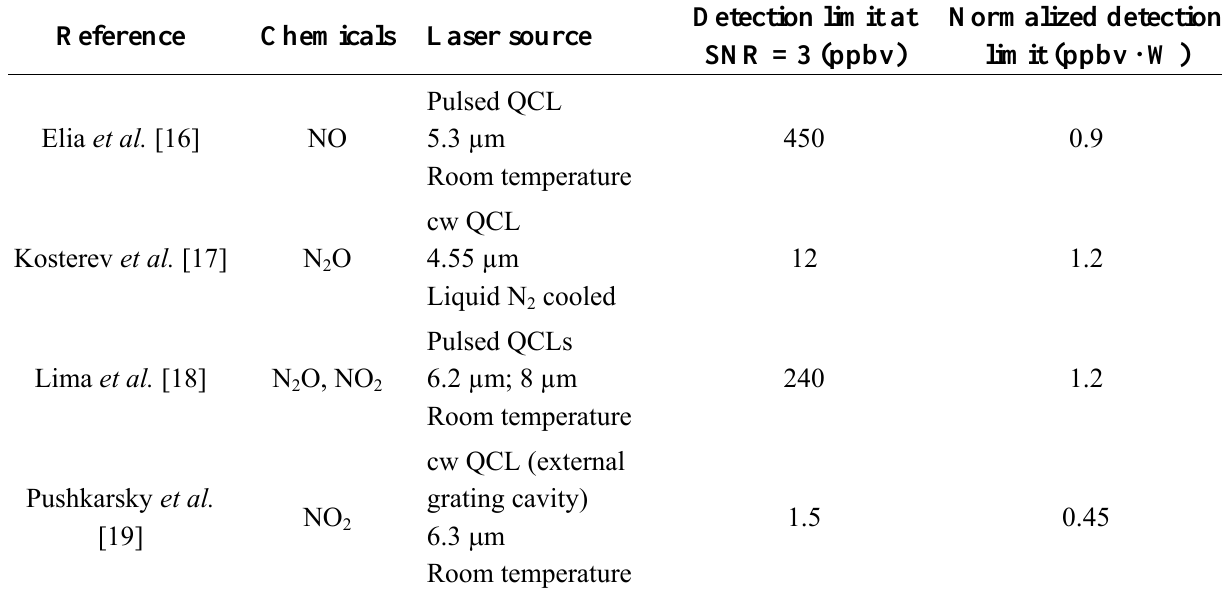
Table 1. State of the art of optical spectroscopic detection of NO PA